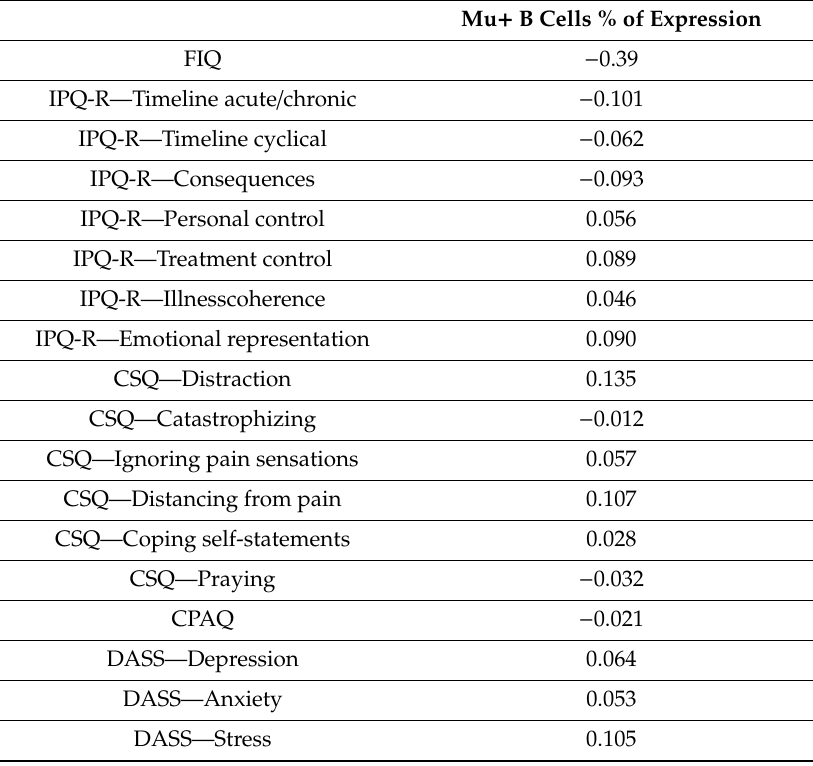
Table 2. Mu + B cells percentage of expression had no significant correlations with any psychological aspects investigated. Pearson’s correlations between Mu + B cells percentage of expression and total FIQ score, IPQ-R subscales, CSQ subscales, total CPAQ score and DASS subscales. Mu + B Cells % of Expression FIQ − 0.39